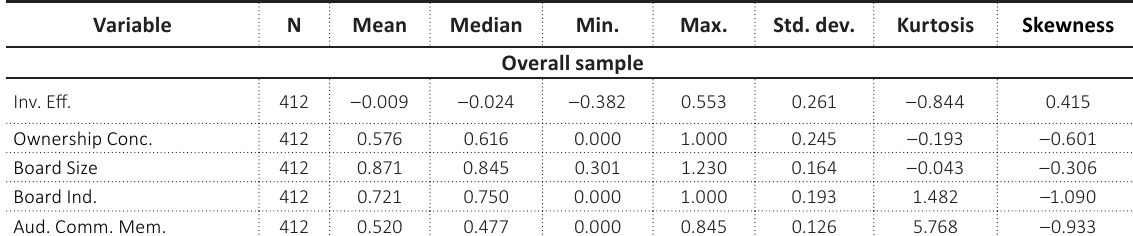
Table 1. Descriptive statistics of the